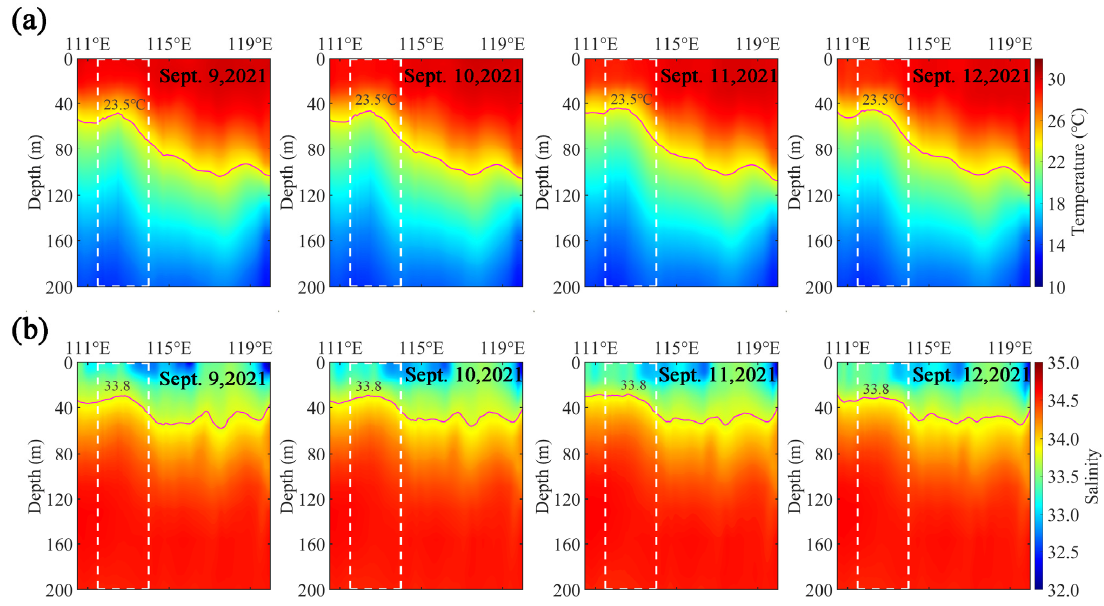
Figure 8. Vertical profile of ( a ) temperature and ( b ) salinity averaged along the latitude before and after the passage of STS “Conson”. Before the passing of STS (9–10 September 2021), after the passing of STS (11–12 September 2021). Vertical profile of the white dotted line box was the black box A in Figure 1. The red lines represent ( a ) 23.5 °C isotherm and ( b ) 33.8 isohaline.